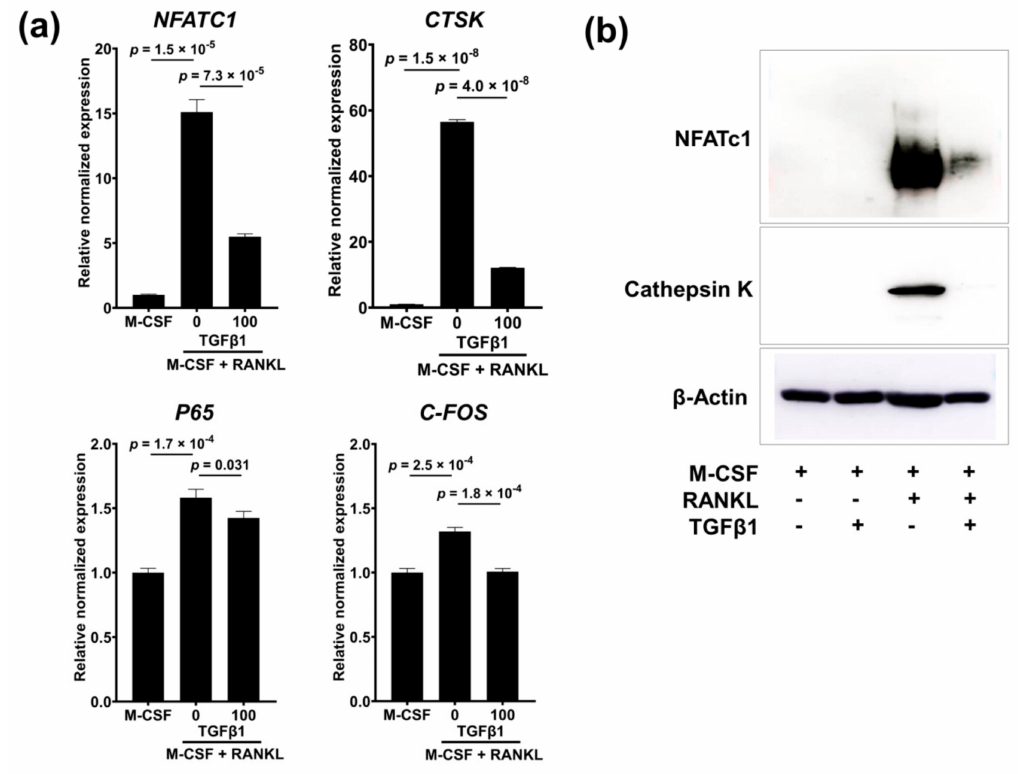
Figure 4. Inhibitory e ff ect of TGF β 1 on RANKL-induced expression of nuclear factor of activated T cells, cytoplasmic 1 (NFATc1) and cathepsin K in human peripheral blood monocytes (PBMs). PBMs were cultured at a cell density of 2.0 × 10 5 cells / well in a 24-well culture plate, in the presence of M-CSF (50 ng / mL) and RANKL (100 ng / mL), with and without TGF β 1 (100 ng / mL), for 1–5 days. ( a ) Gene expression levels of NFATC1 , CTSK , P65 , and C-FOS were measured by real-time reverse-transcription polymerase chain reaction (RT-qPCR). Total RNA from PBMs cultured for 24 h was harvested for p65 and c-Fos. Total RNA from PBMs cultured for 48 and 96 h was harvested for NFATc1 and cathepsin K, respectively. The data were normalized to ACTB expression and are presented as the mean ± standard deviation ( n = 3). ( b ) Protein levels of NFATc1 and cathepsin K were determined by Western blotting. Proteins were harvested from PBMs cultured for 120 h. A representative photograph of three independent experiments from di ff erent healthy donors is